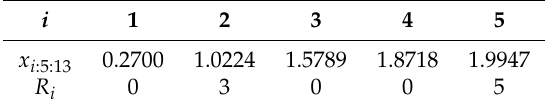
Table 5. A progressive censored sample of the logarithmic lifetime of the insulating fluid. i 1 2 3 4 5 x i :5:13 0.2700 1.0224 1.5789 1.8718 1.9947 R i 0 3 0 0